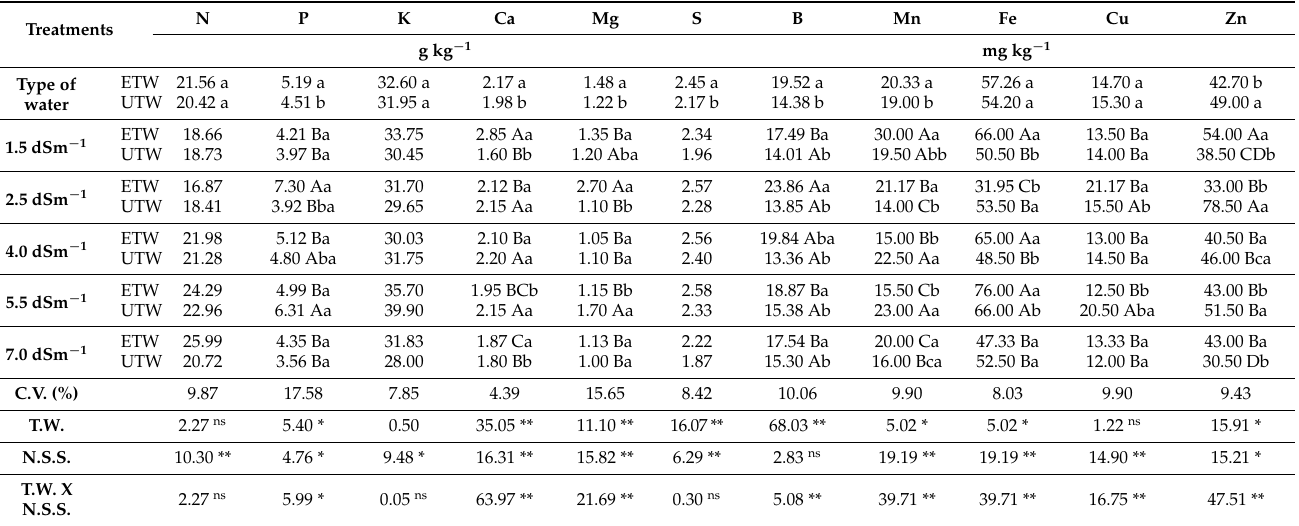
Table 3. Nutrient contents in tomato fruit in response to electrical conductivity application with electromagnetically treated water (ETW) and untreated water